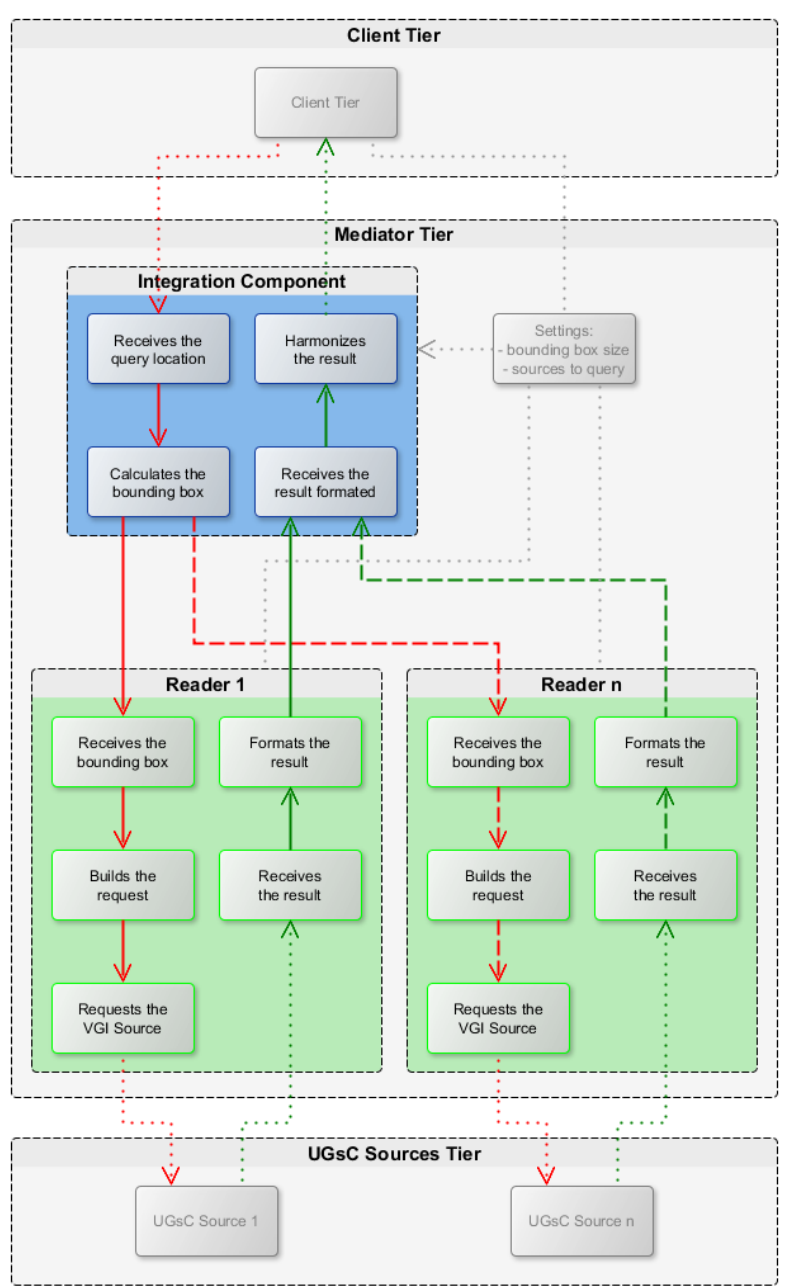
Figure 2. Detailed architecture of the data integration model (note: input, output, and settings’ workflows respectively in red, green, and grey colors). VGI, volunteered geographic information.